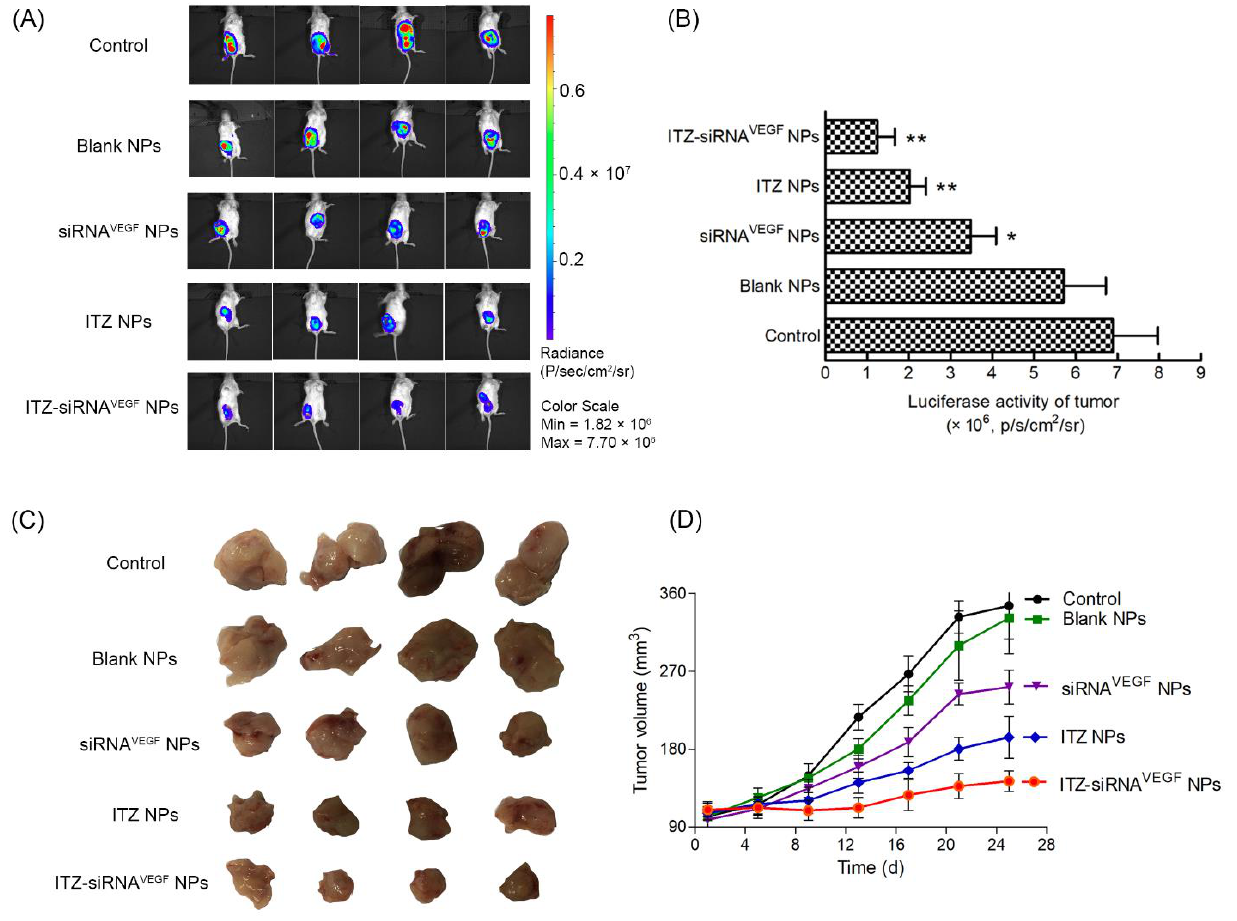
Figure 8. In vivo anti-tumor effect of systemic administration of ITZ and VEGF siRNA co-delivering NPs in 4T1 tumor-bearing mice. Female BALB/c mice (4–6 weeks old, 18–22 g) in each group were orthotopically inoculated with 1 × 10 5 4T1 Luc cells in the fourth mammary fat pad in the right lower abdomen. The mice were intravenously injected with various formulations (N/P = 30, C/N = 1/5; ITZ content: 8.28%). ITZ was administered at a dose of 10 mg/kg, and VEGF siRNA was administered at a dose of 3 mg/kg. ( A ) In vivo bioluminescence imaging analysis of mice after administration with various formulations. ( B ) Quantitative estimation by bioluminescent analysis. * p < 0.05, ** p < 0.01 vs. control group ( n = 3). ( C ) The tumor photos ( n = 4). ( D ) The changes in tumor volume due to in vivo antitumor effects of ITZ and VEGF siRNA co-delivering NPs ( n = 4).